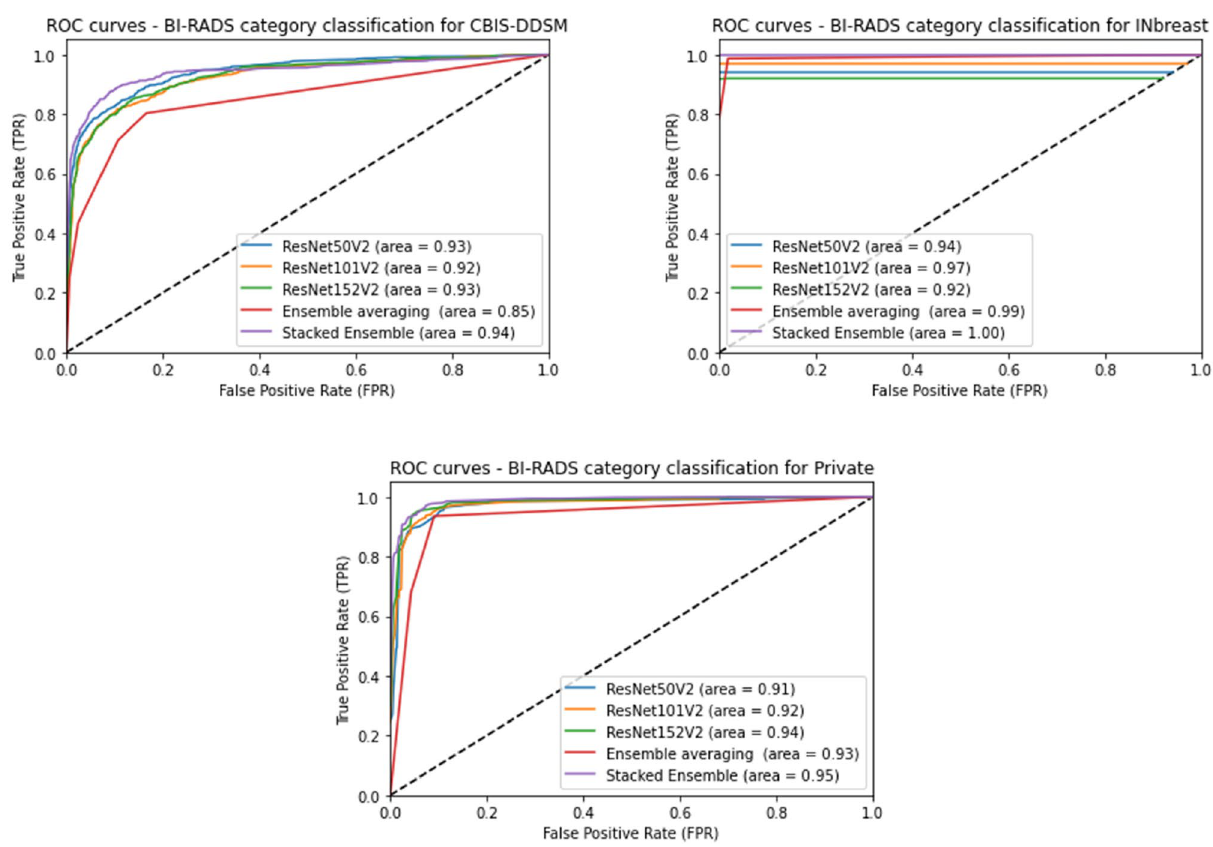
Figure 7. Performance of BI-RADS classification using different models in terms of ROC curves and AUC score.